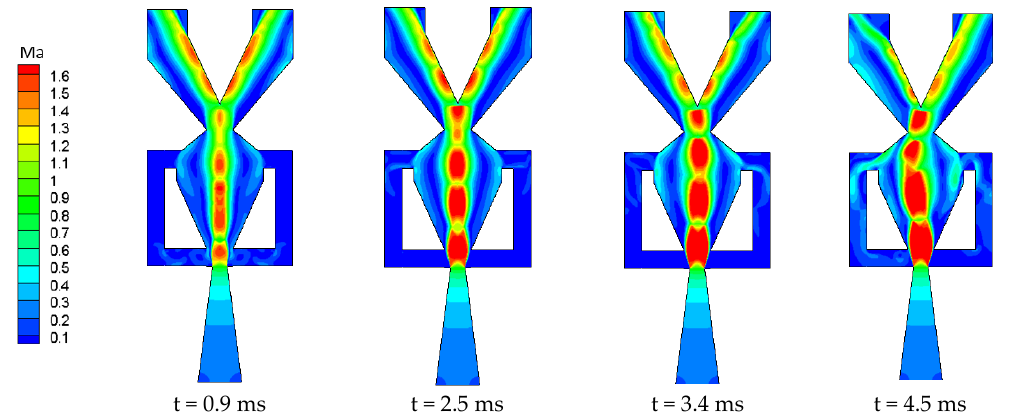
Figure 6. Mach number distribution at different times in model M 5, 9.